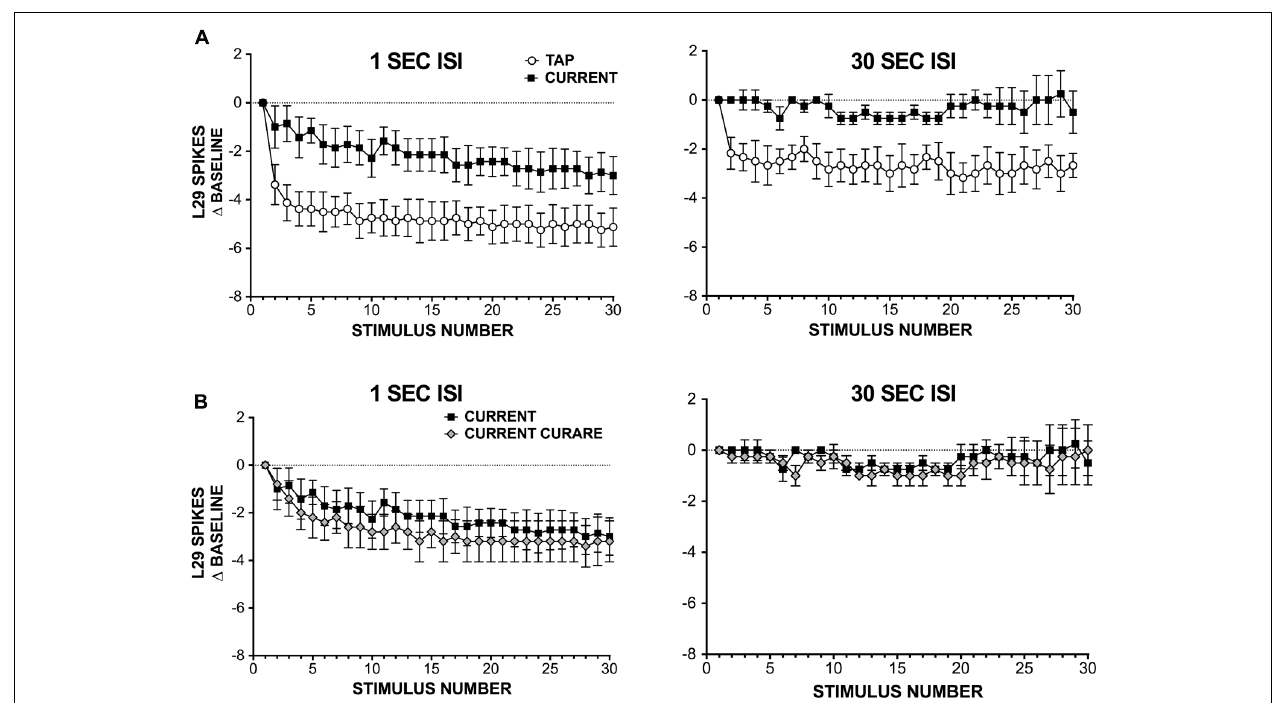
greater reduction seen using siphon tap. At a 30 s ISI (right), only siphon taps produced a significant change. (B) L29 responses during repeated current injection at ether a 1 s (left) or 30 s (right) in the presence of 100 μ m curare. Blocking inhibition has no significant effect on L29 activity.